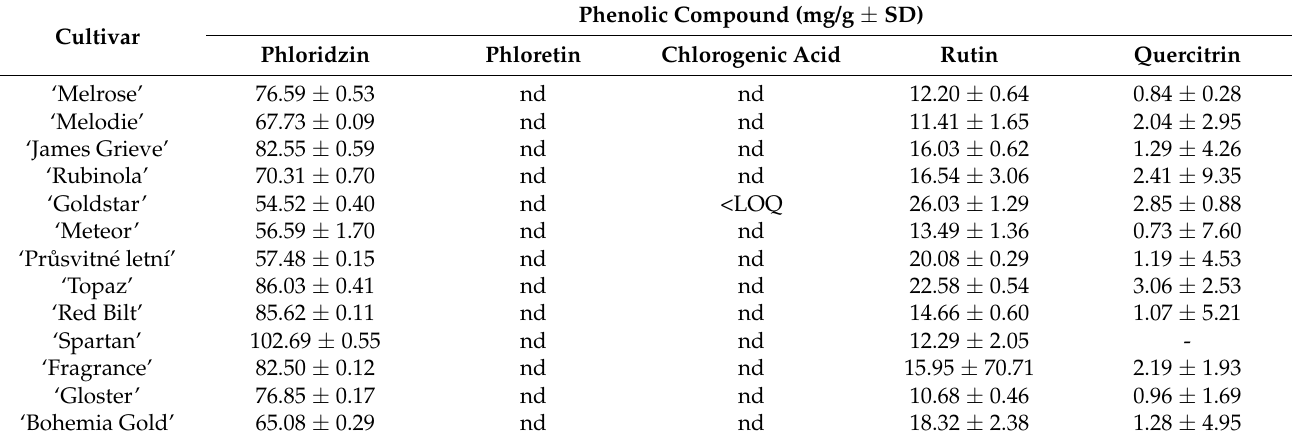
Table 4. Content of phenolic compounds in bark of 13 cultivars (all values in mg/g of dried weight